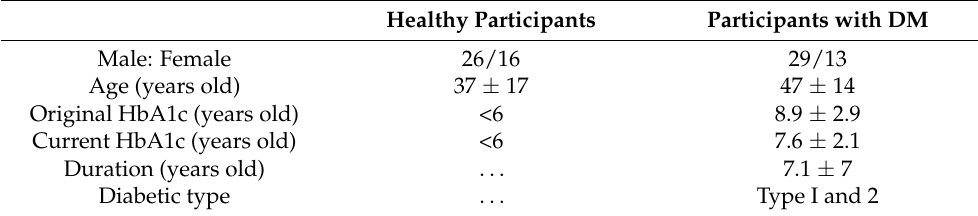
Table 4. Basic characteristics of the